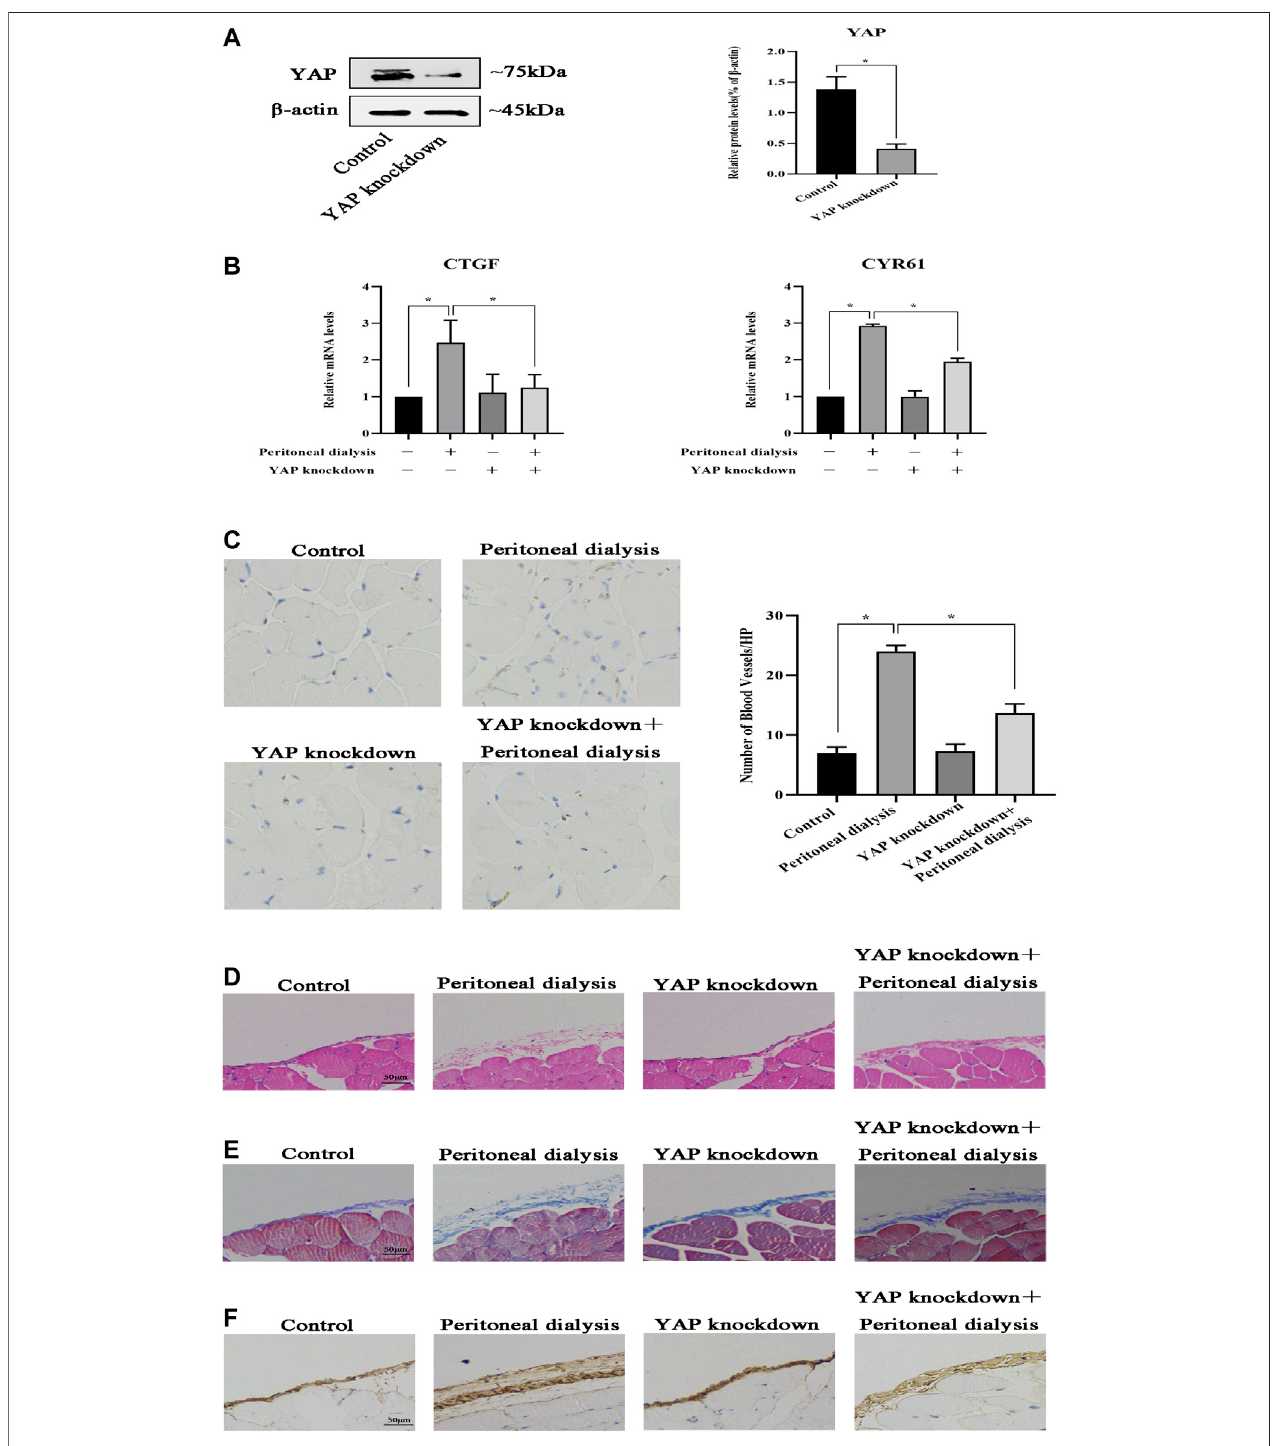
FIGURE6| YAPisinvolvedinperitonealangiogenesis invivo .Micewere injected intraperitoneallyonce withYAPrecombinantAAV atadose of1.00E +11 v.g/ml. After 21 days, the mice were injected intraperitoneally with PDS for another 30 days. Control: normal control; peritoneal dialysis: standard PDS (10 ml/kg/day); YAP knockdown: YAP recombinant AAV (1.00E + 11 v.g/mL); YAP knockdown + peritoneal dialysis: YAP recombinant AAV (1.00E + 11 v.g/mL) + standard PDS (10 ml/kg/ day). (A) WesternblottingwasusedtodetectYAPproteinexpressionoftheparietalperitoneuminthecontrolgroupandtheYAPknockdowngroup. (B) CTGFand CYR61 mRNA levels in the parietal peritoneum were analyzed by real-time PCR assay. Data represent mean ± SEM (* p < 0.05). (C) Representative fi elds showed the different vessel densities in the parietal peritoneum after immunohistochemistry staining with anti-CD31 ( × 100). The number of blood vessels per fi eld after anti-CD31 staining, assessed in the mesentery under × 100 magni fi cation (graph). (D) HE staining of mesothelial cells of the parietal peritoneum in mice showed mesothelial injury and fi brosis (scale bar (cid:2) 50 μ m). (E) Peritoneal thickening and ECM deposition were observed using Masson ’ s trichrome staining (scale bar (cid:2) 50 μ m). (F) Tissues of the peritoneum were subjected to immunohistochemical staining for Collagen I expression (scale bar (cid:2) 50 μ m). Frontiers in Pharmacology |